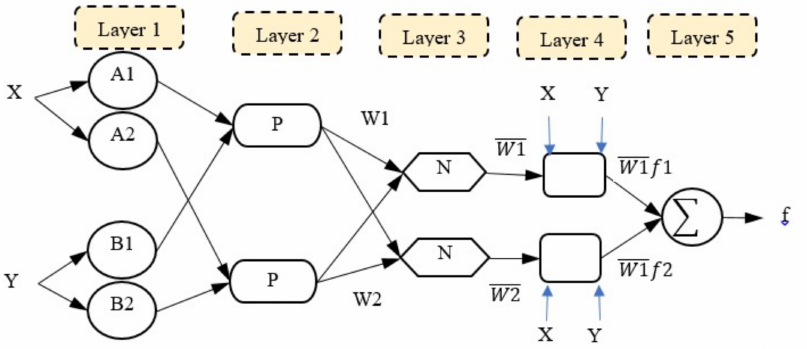
Figure 4. Architecture of adaptive neuro-fuzzy inference system